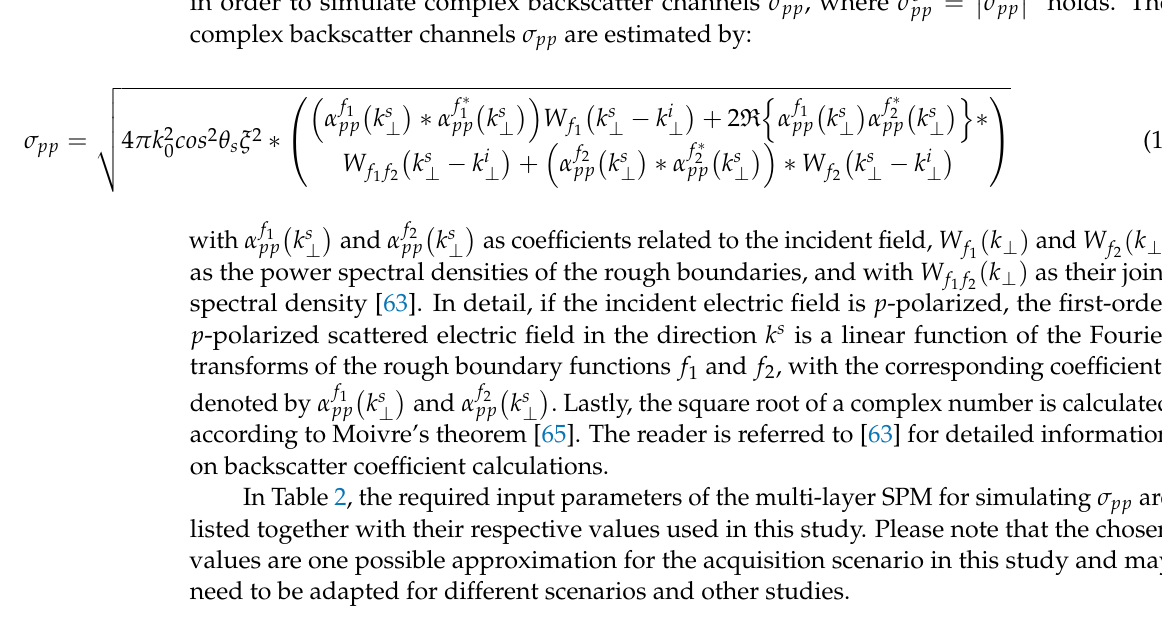
Table 2. Required input parameters of the multi-layer SPM for σ pp simulations with the applied values in this study. Parameter Value Frequency, f [MHz] 430 Number of layers, N [–] 2 Incidence angle in range, θ i , and azimuth, ϕ i [ ◦ ] θ i from AirMOSS; ϕ i = 0 Scattering angle in range θ s , and azimuth, ϕ s θ s = θ i ; ϕ s = 180 [ ◦ ] z-coordinates of the respective boundary layer, d 1 = λ /2 = 34.86 d 1 [cm] Surface roughness parameters of each